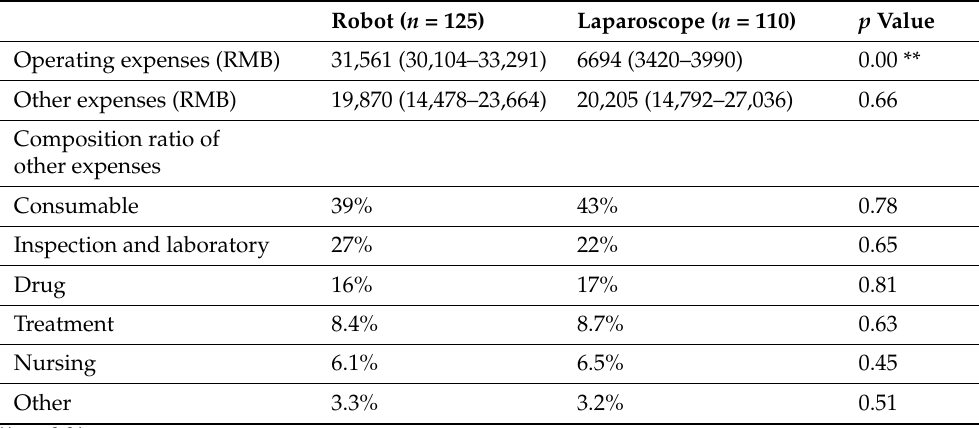
Table 3. Details of hospitalization